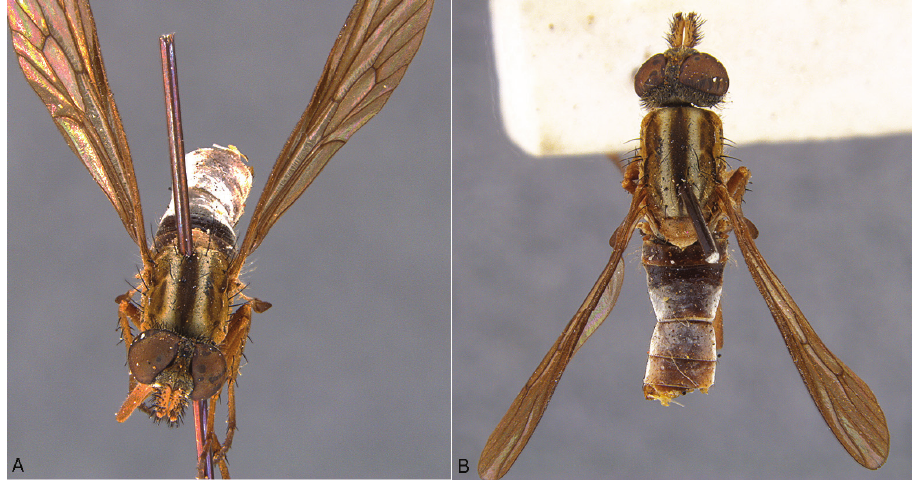
Figure 7. Sidarena flavipalpa sp. n.: A Male, anterior view B same, dorsal view.